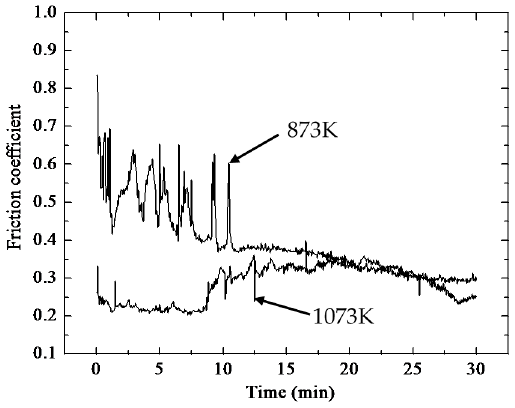
Figure 6. Friction coefficient curves of TF550 alloy as a function of wearing time at high temperatures of 873 and 1073 K.